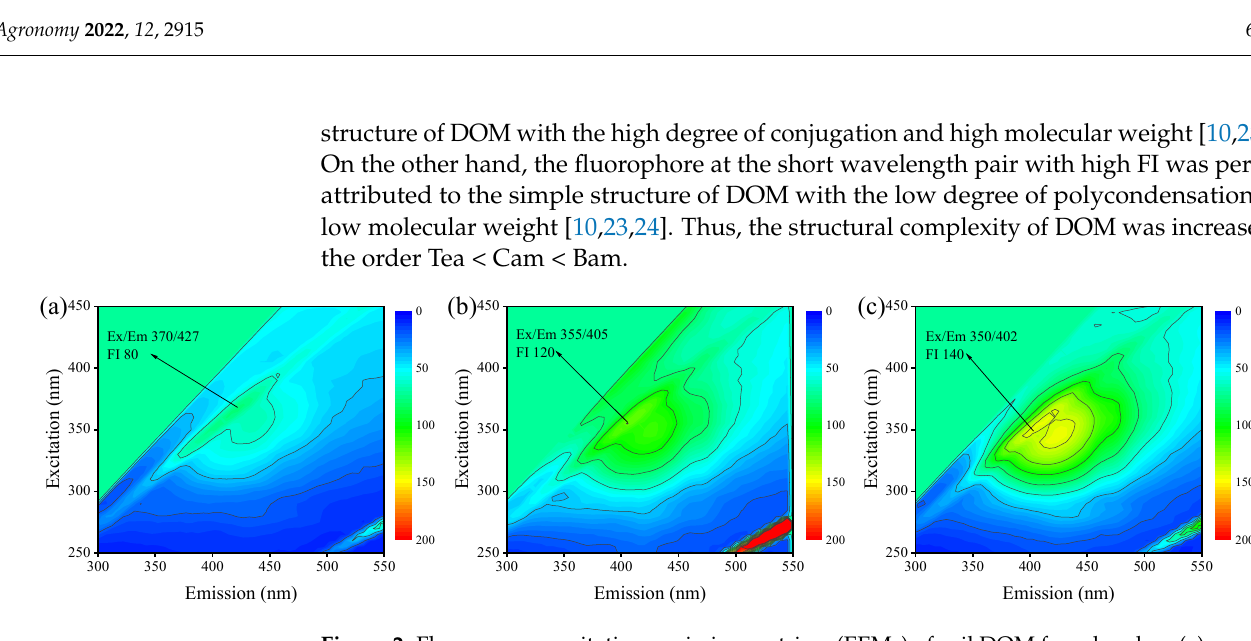
Figure 2. Fluorescence excitation–emission matrices (EEMs) of soil DOM from bamboo ( a ), camphor ( b ), and tea ( c ) plantations. Contour lines based on DOM-normalized fluorescence intensity (FI) values. Arrows showing the location and normalized FI value of the fluorophore.